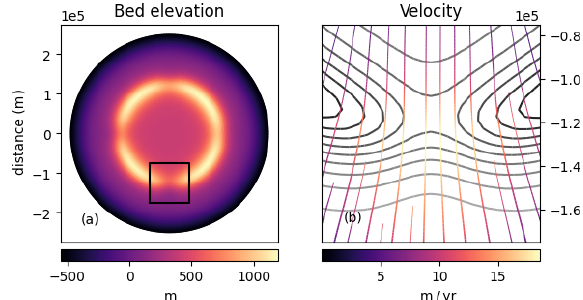
Figure 6. Synthetic ice sheet simulation. (a) The bed elevation pro- file consists of a ring of mountains with valleys of varying depth sur- rounding a flat plateau where the ice sheet is initialized. The black square outlines the domain of panel (b) which shows the velocity of the ice as it passes through the southernmost mountain pass, with contours of the bed elevation shown in